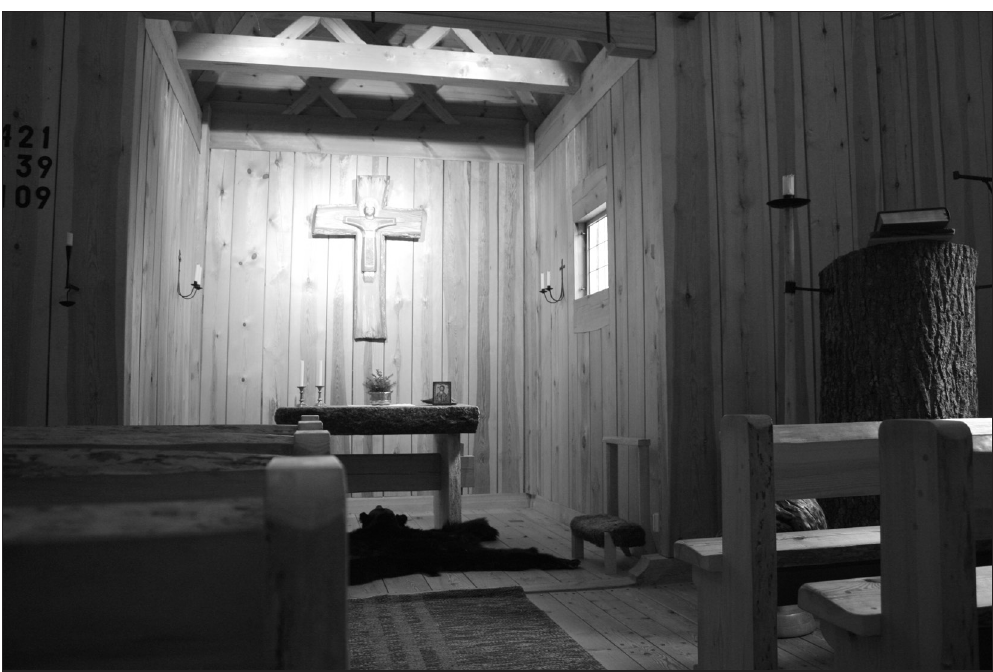
Figure 4: The interior of Skaga chapel, reconstructed for the second time in 2001. The tree trunk pulpit refers to a written description from the early nineteenth century. The bear fur, stolen and replaced several times, is based on a well spread myth about two hunters who discover an abandoned church with a hibernating bear. (Photo: Eva Löfgren,